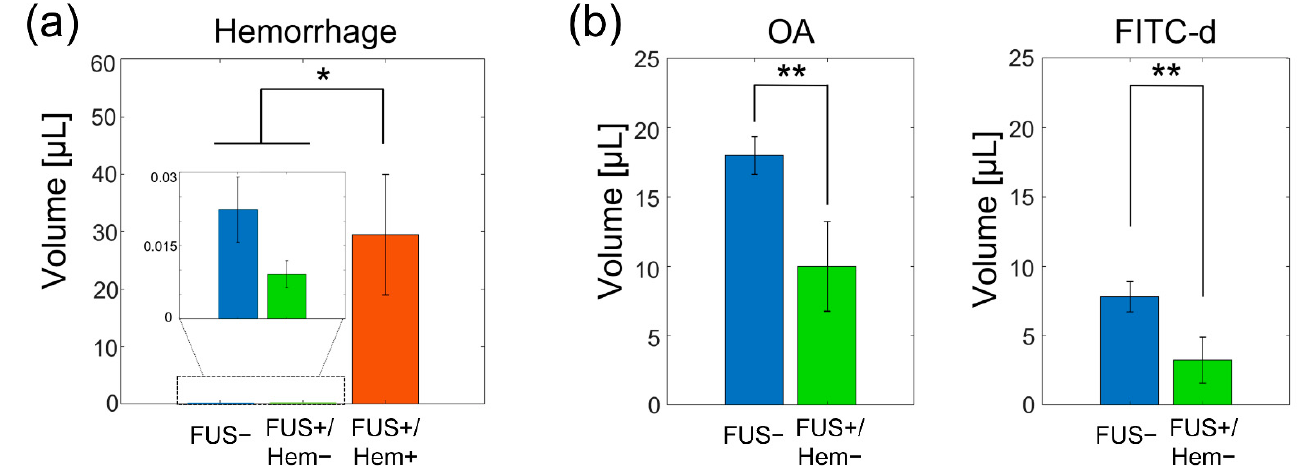
Figure 3. Comparisons of hemorrhage and tracer volume. ( a ) The hemorrhage volume obtained from the FUS − ( n = 6, in blue), FUS+/Hem − (the rats without showing the hemorrhage; n = 5, in green), and FUS+/Hem+ ( n = 4, in red) groups. ( b ) Tracer volume comparisons between the FUS − (in blue) and the FUS+/Hem − group (in green) for each tracer type. A statistically signi fi cant di ff erence is indicated by ‘*’ (Fisher’s least significant difference (LSD) post hoc analysis followed by the Krus- kal–Wallis test, p < 0.05), and ‘**’(one-tailed, Mann–Whitney U test, p < 0.05). The error bars indicate the standard error.